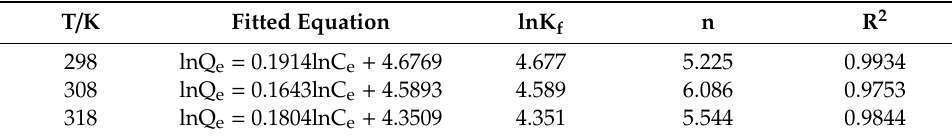
Figure 4. Linear relationship between lnQ e and lnC e. Table 2. Fitted Freundlich equations and